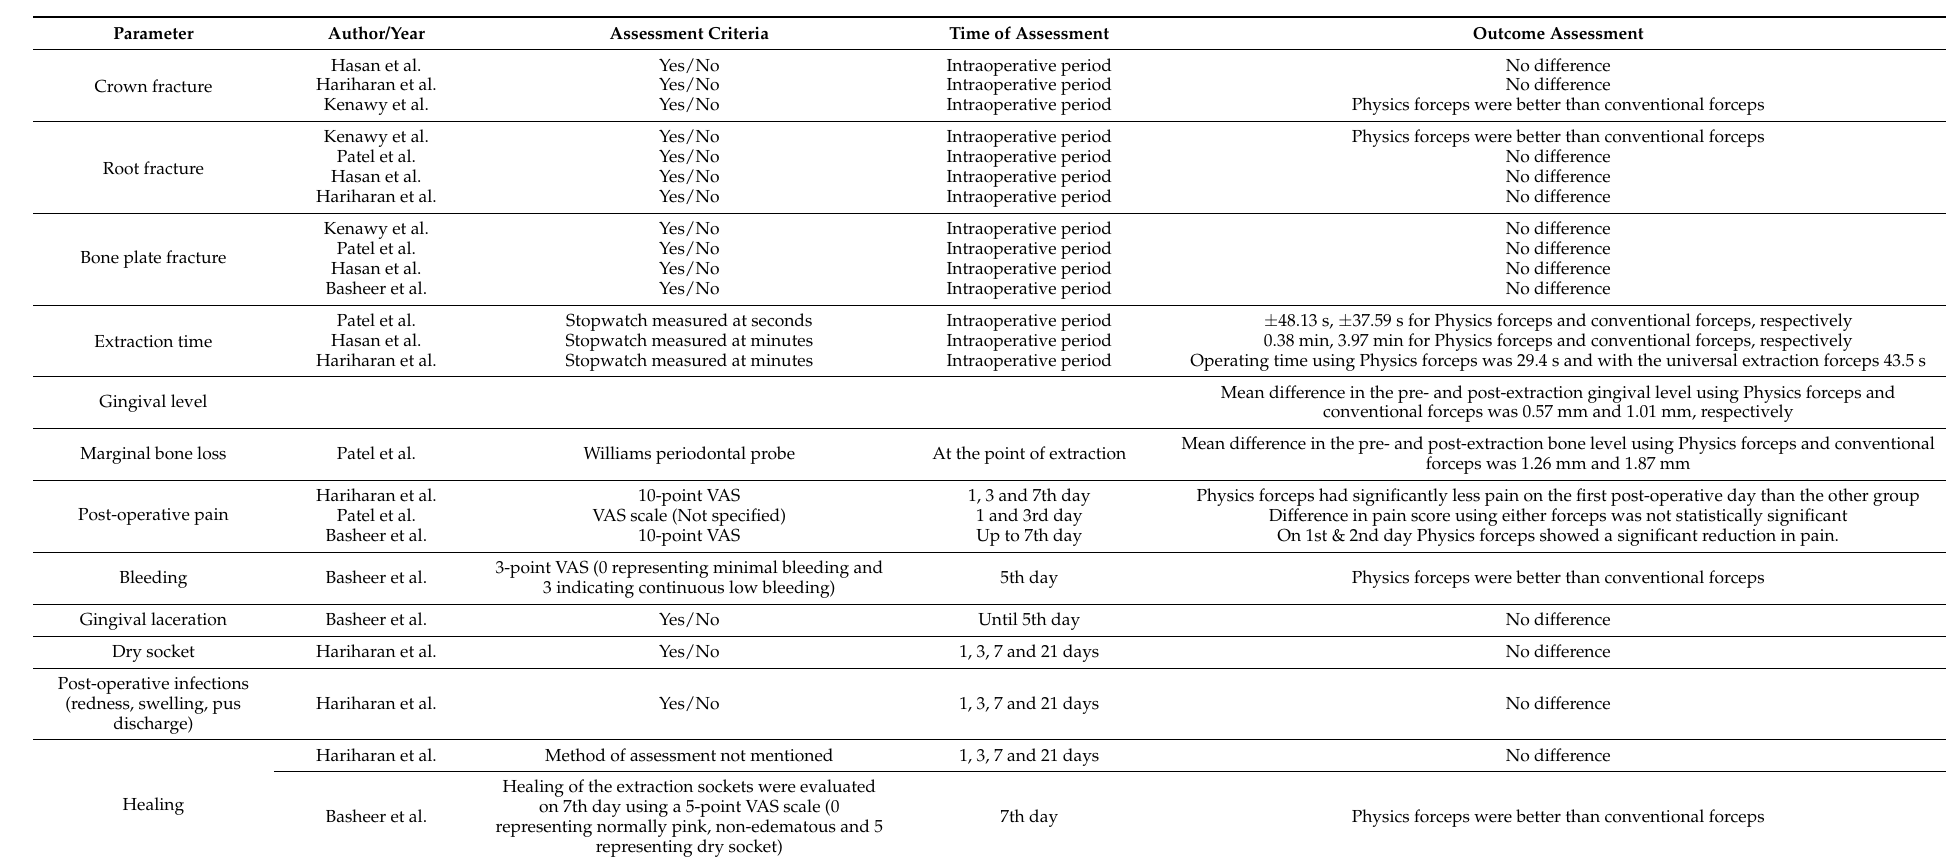
Table 3. Characteristics of included